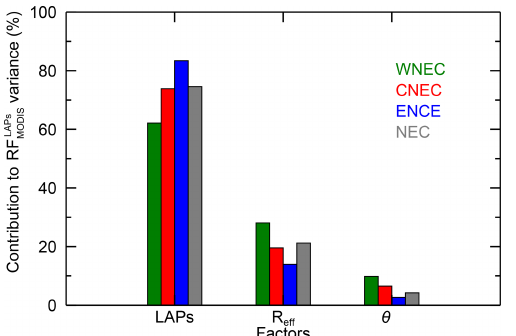
Figure 7. Fractional contribution of average I LAPs (the indicator of LAPs), R eff , and solar zenith angle ( θ ) to the spatial variance of RF LAPs in January–February for 2003–2017. MODIS